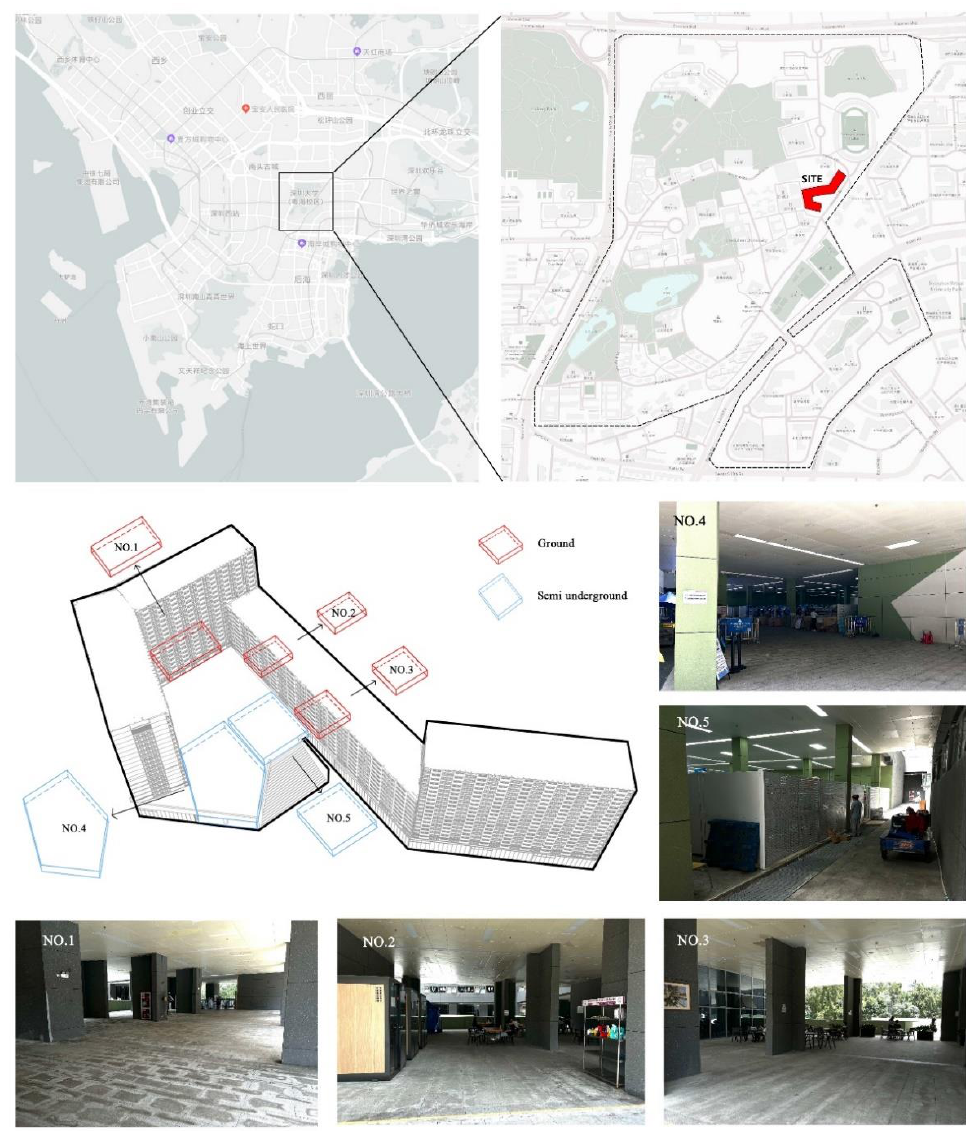
Figure 3. Study site selection.